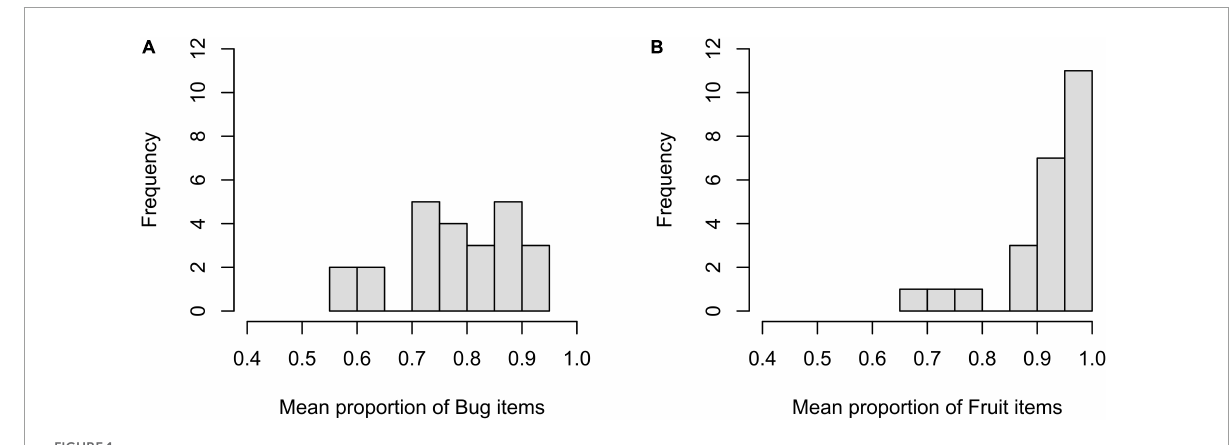
FIGURE1 Histogram of mean proportion of the bug (A) and fruit (B) items for by-item